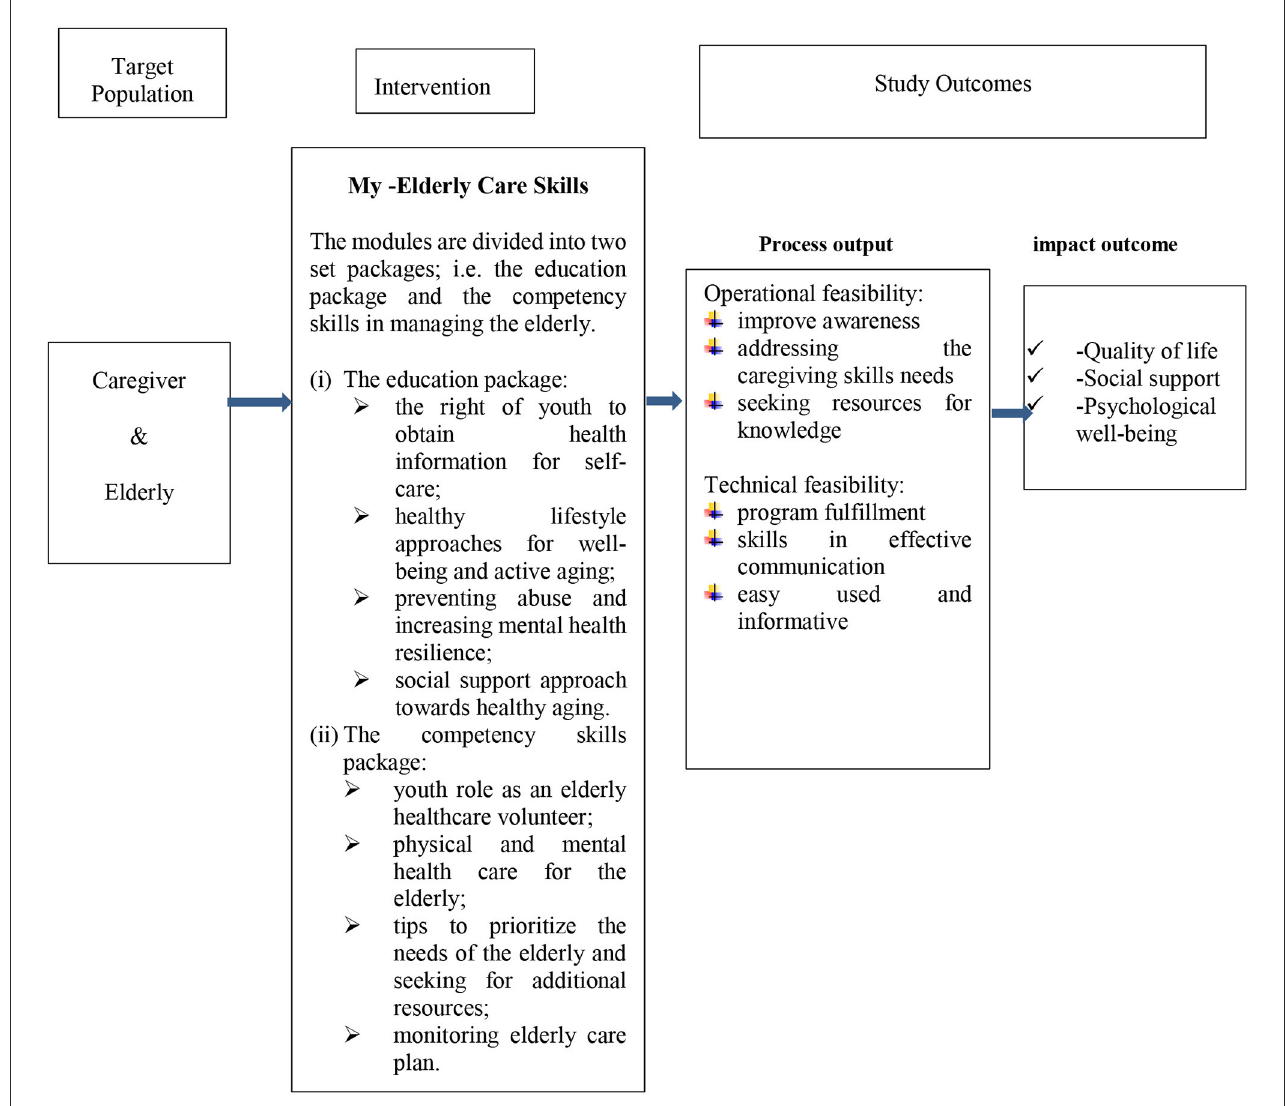
FIGURE1 Visualization of study framework and